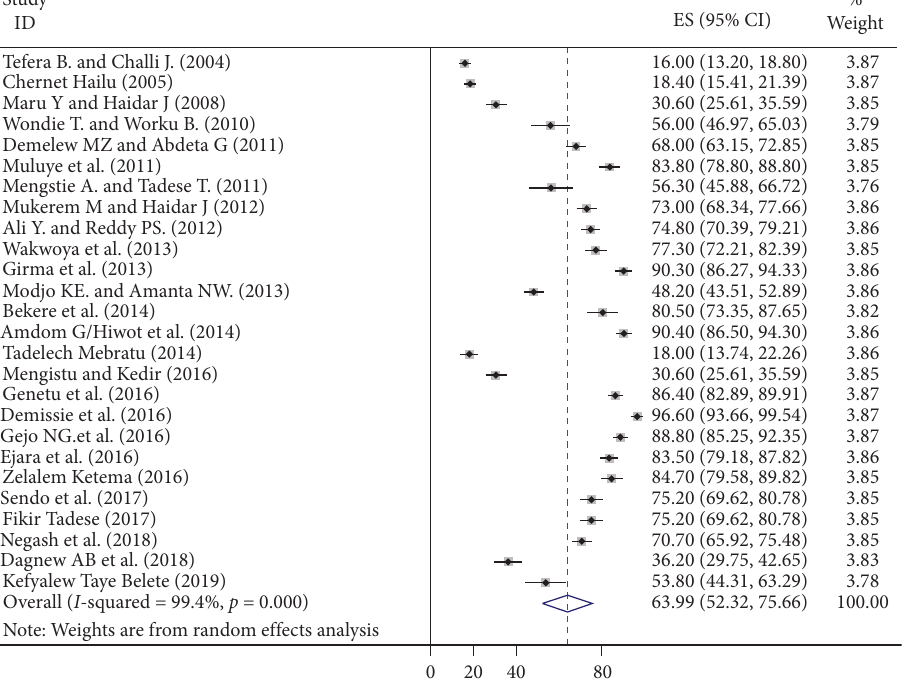
Figure 2: Forest plot showing the pooled prevalence of exclusive breastfeeding practice of HIV-exposed infants in